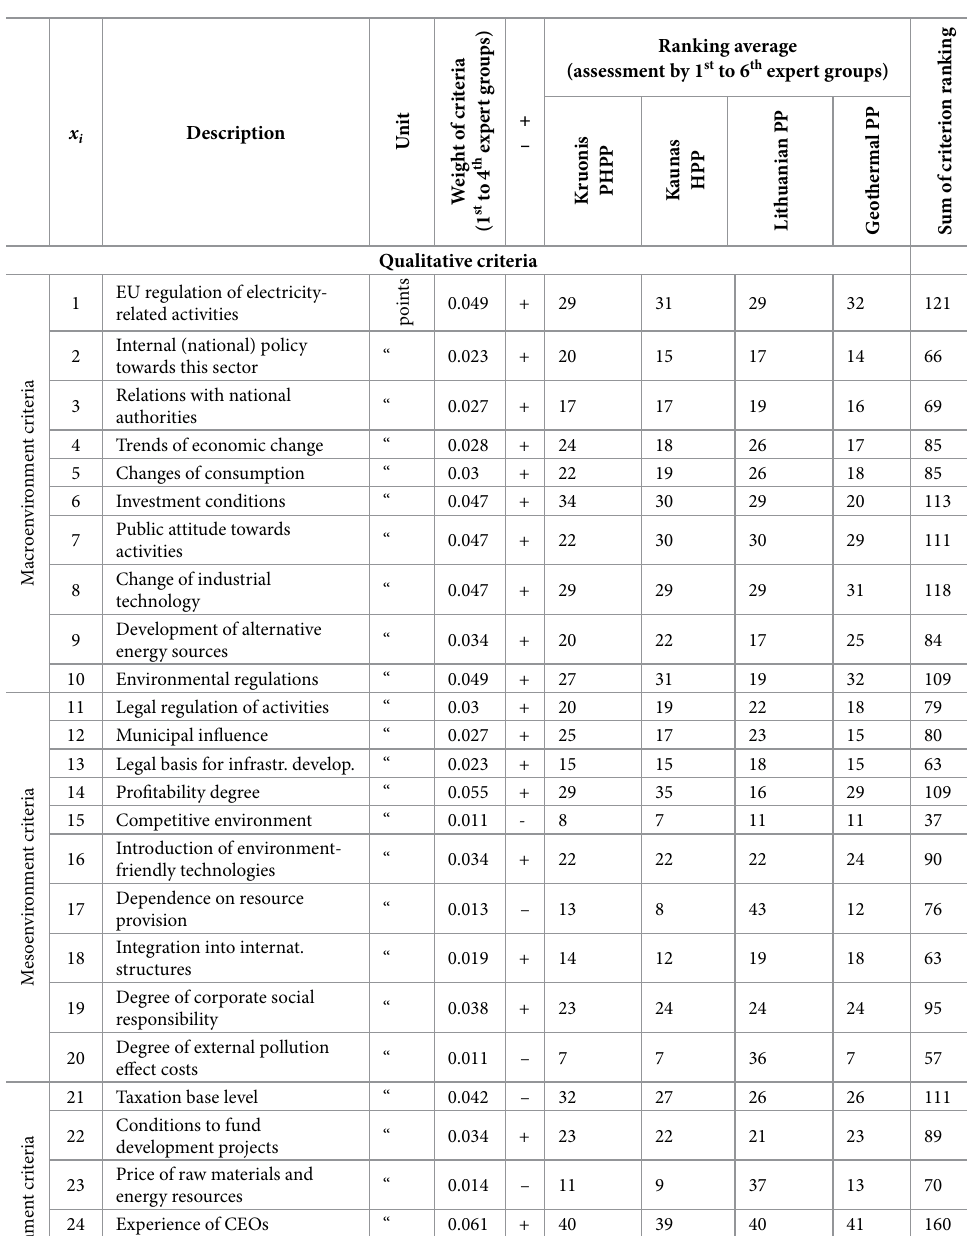
table 5. Measurement of values and weights of qualitative and quantitative criteria x i description